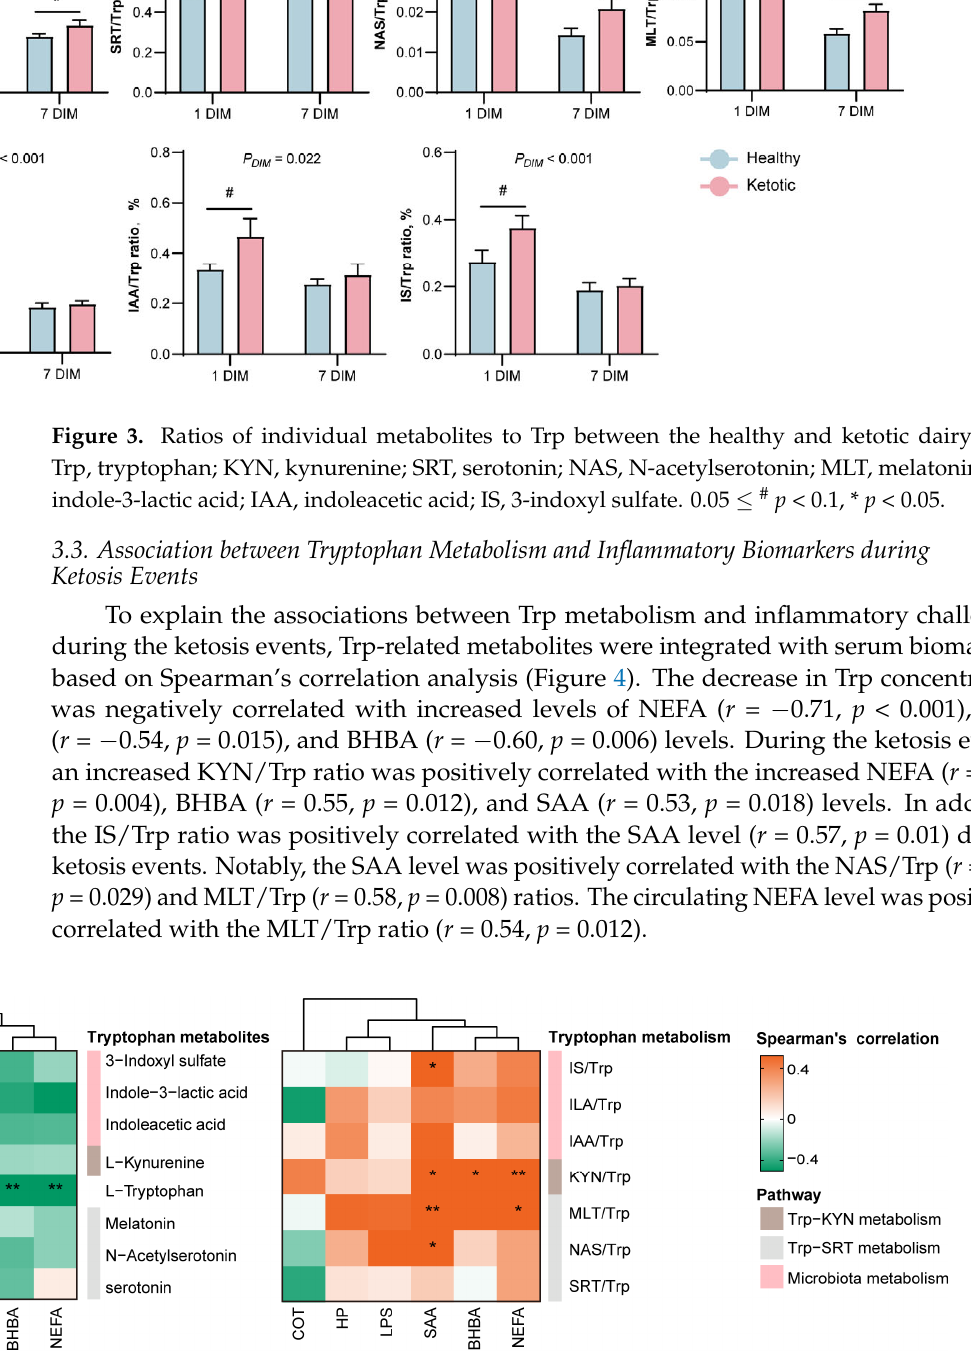
Figure 2. Tryptophan (Trp) metabolism in dairy cows during the ketosis event. ( A ) Diagram of Trp metabolism pathway, including kynurenine, serotonin, and microbiota pathways. ( B ) Levels of Trp and its main metabolites between the healthy and ketotic groups at 1 and 7 days in milk (DIM). 0.05 ≤ # p < 0.1, * p < 0.05, and ** p < 0.01.